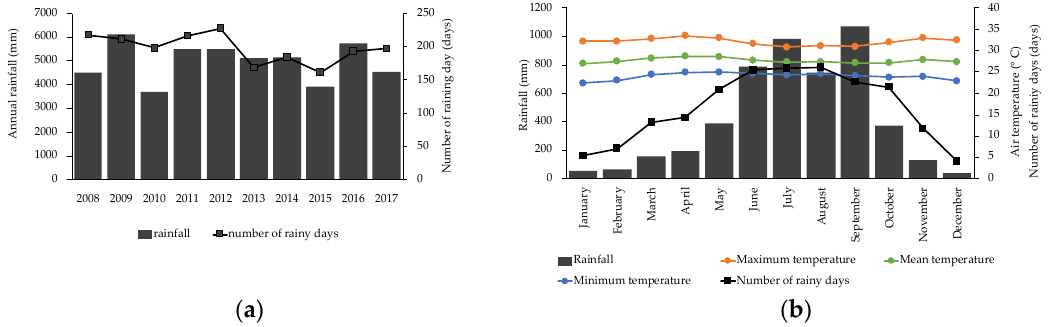
Figure 2. Climatic data from the Klong Yai Weather Station, Trat Province from 2008 to 2017 (Meteorological Department of Thailand): ( a ) annual rainfall and number of rainy days and ( b ) average monthly rainfall, average number of rainy days, maximum temperature, minimum temperature, and mean temperature.